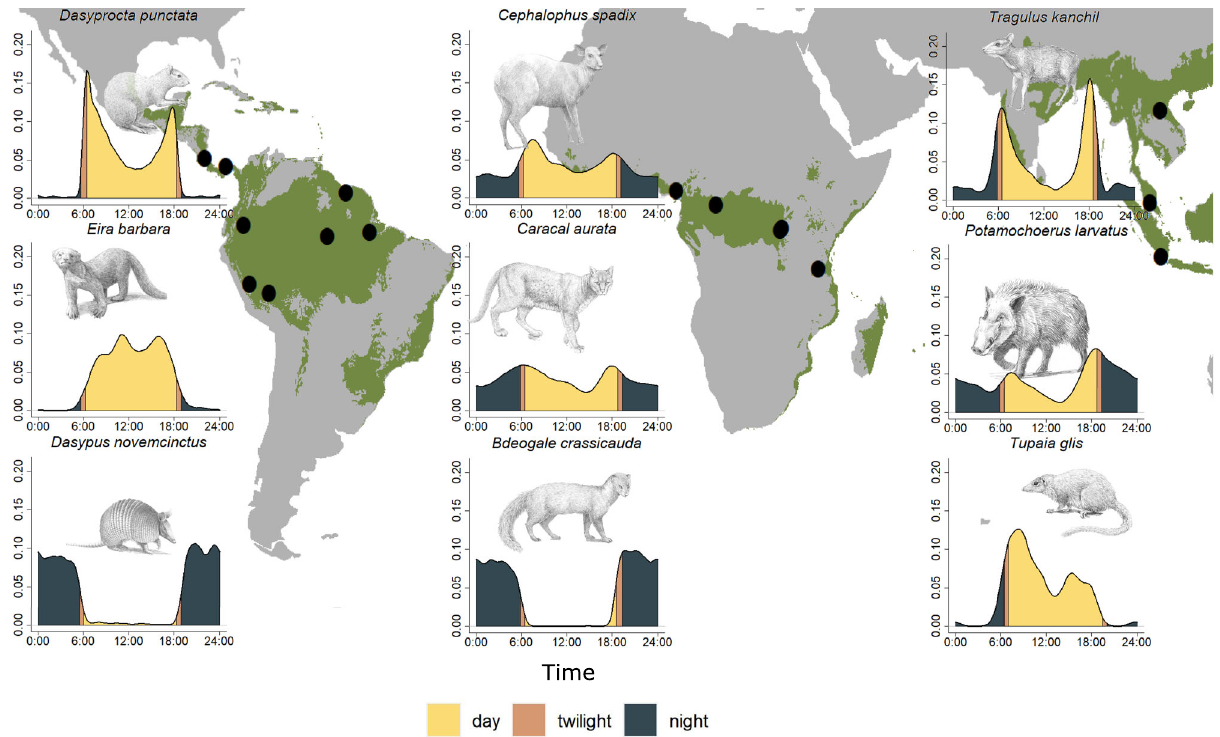
Fig. 2 | Map of the study areas and activity density examples. Mammal activity data were collected using the standardized TEAM camera-trapping protocol in 16 protected areas (black dots in background) situated in 14 countries and tropical forests (areasshaded green onthemap in thebackground)in three biogeographic